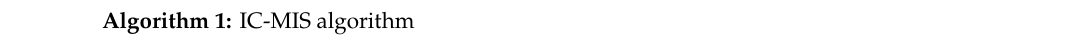
Figure 3. Examples of IC-MIS algorithm: ( a ) Initially, all nodes are white, and v 1 as the first dominating node, set state as black; ( b ) v 1 broadcasts message, v 2 , v 3 , v 4 receive the message, set state as gray; ( c ) v 2 , v 3 , v 4 broadcast messages, v 5 , v 6 , v 7 , v 8 , v 9 receive the message, set state as blue; ( d ) v 11 has the high Pro , set state as red; ( e ) v 10 and v 12 as the next real dominating nodes; ( f ) when v 10 and v 12 as the dominating nodes, update v 5 , v 6 , v 7 , v 8 as gray.